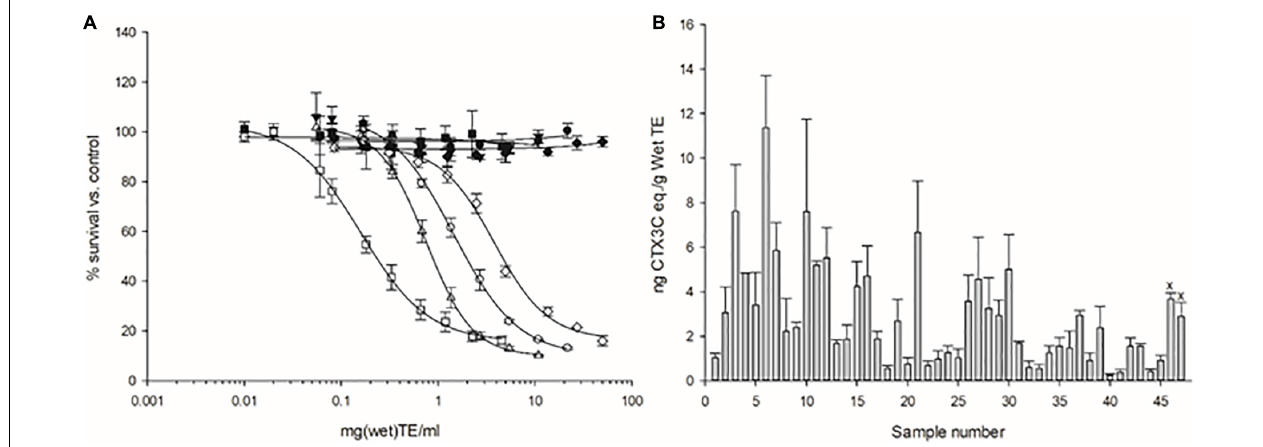
FIGURE 4 | (A) Combined concentration-response curves of N2a cells without (–) the addition of ouabain (O) and veratridine (V) (– OV, solid symbols) and with the addition of OV (+OV, open symbols), when exposed to various concentrations of semi-purified extracts of fish. Lines are high (square, sample #21), medium (triangle, sample #35), medium-low (circle, sample #1), and lowest (diamond, sample #40) toxicity based on the dose-response curves representing high to low toxin concentration estimates among the sampled lot. OV-LS N2a cells were exposed to 0.22/0.022 mM O/V. Dose-response curves were used to measure the effective concentration (EC) for 50% reduction in cell survival. (B) Bar graphs with error bars representing the toxin concentration (based on the mean EC50’s measured) expressed as ng CTX3C eq. per gram wet tissue eq., generated from the dose-response curves: data display all samples tested and all replicates. Symbol ‘x’ above the error bar indicates samples from meal remnants from lot # 122 (samples # 46 and 47). Error bars represent the standard deviation from all independent 96-well plate analyses performed for each sample (minimum three independent assays, each assay includes three replicate points).